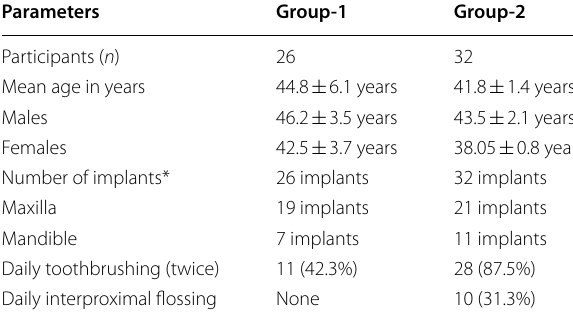
*All implants were located in the region of missing premolars or